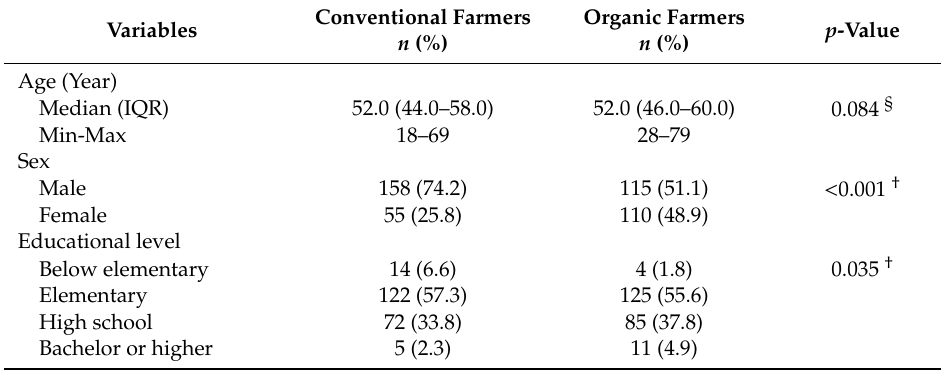
Table 1. Characteristic and risk factors of conventional farmers ( n = 213) and organic farmers ( n = 225) at Round 1